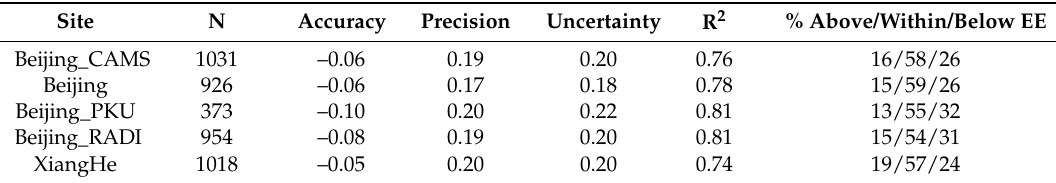
Table 2. Comparative statistics of collocated Himawari-8 and AERONET AODs.